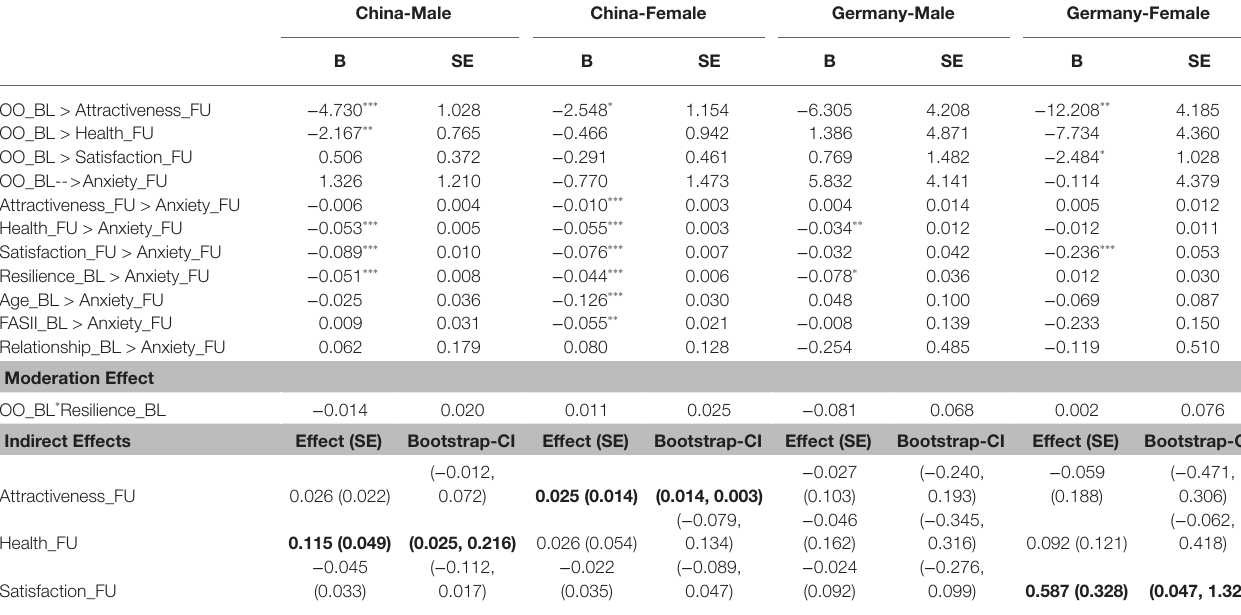
TABLE 5 | Summary of mediated and moderated regression analyses predicting